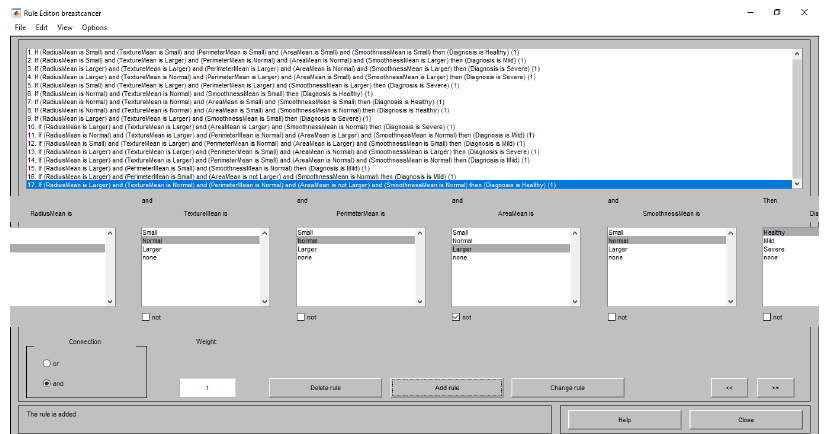
Figure 20. Neuron combines all its input features AND operation.